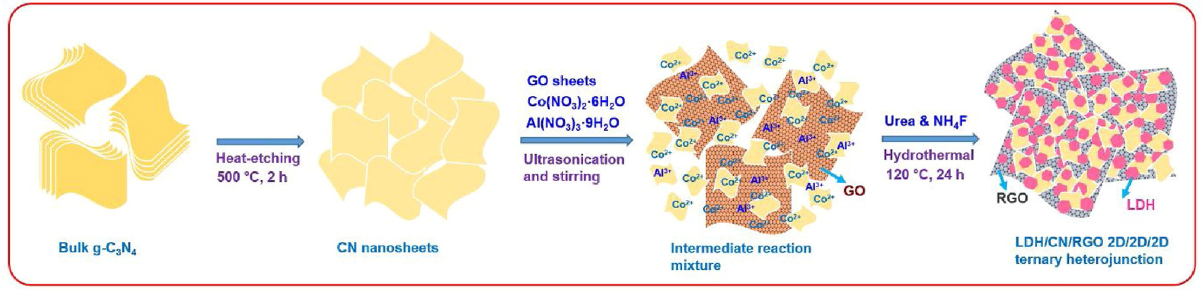
Figure 4: Preparation of the CoAl - LDH/g - C 3 N 4 /RGO ternary photocatalyst. Reproduced with permission from ref. [ 94 ] ; copyright ( 2019 ) ,